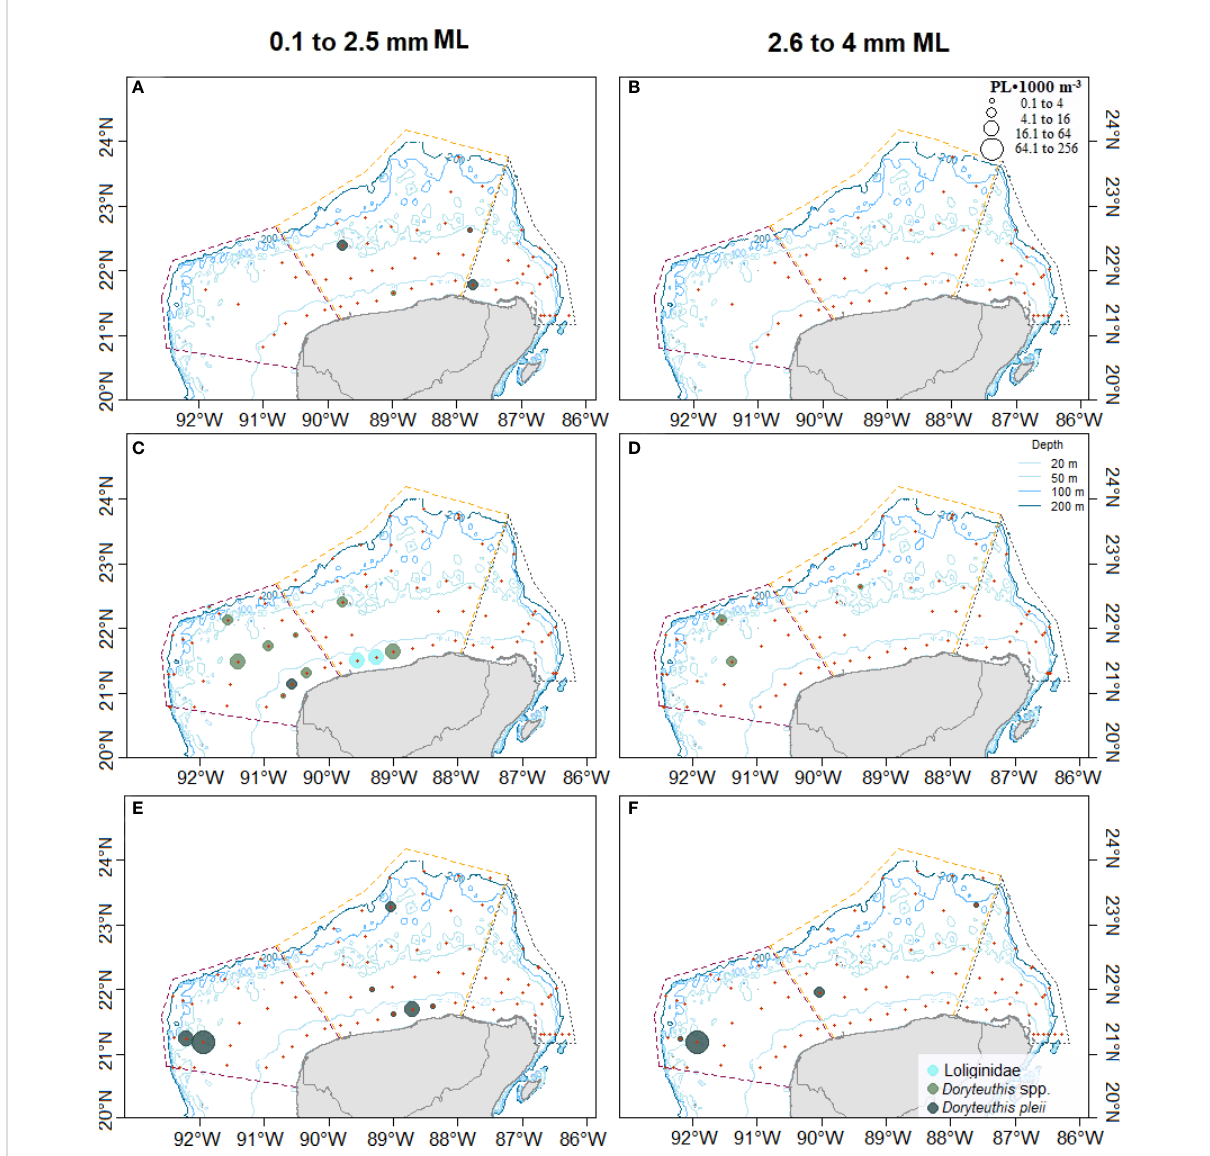
FIGURE 6 Distribution of the abundance of loliginids by cruise and size group in the Yucatan Shelf, Southeastern Gulf of Mexico (A, B) November 2015, (C, D) August-September 2016, and (E, F) July 2018. The dotted lines represent the three zones: Western ( — purple), Central ( — orange), and Eastern ( — gray). Red crosses represent sampling stations.